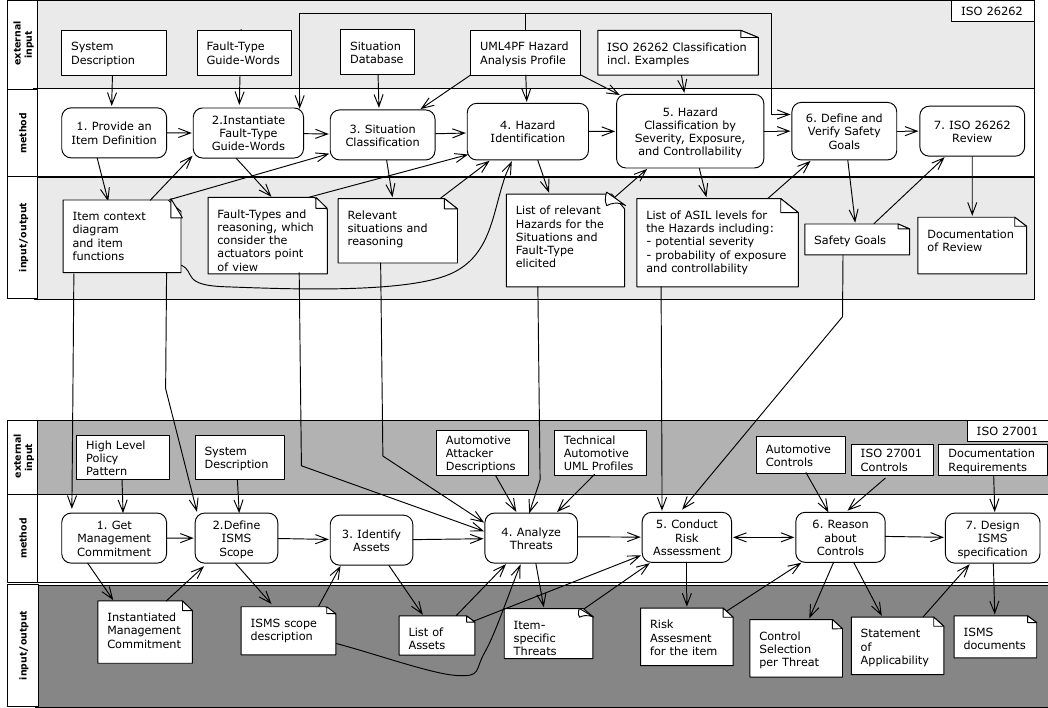
Figure 1. Method